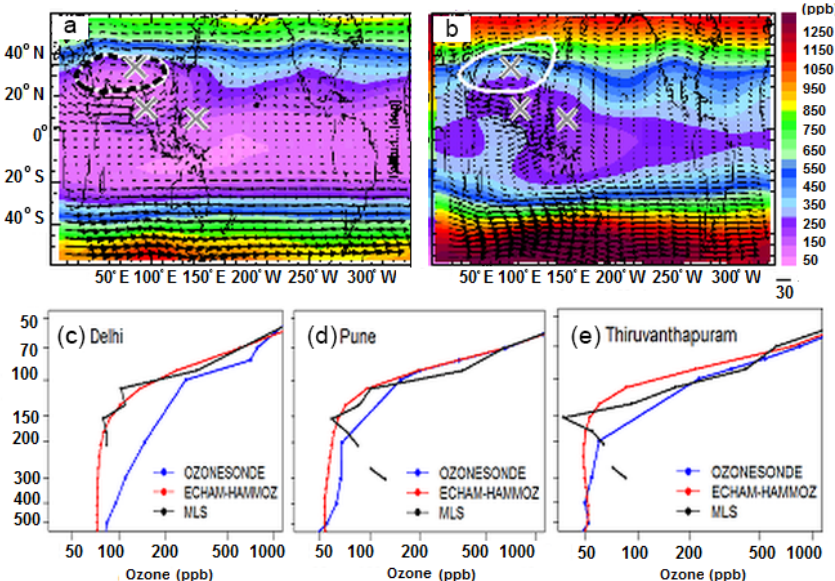
Figure 1. Distribution of ozone mixing ratio (ppb) during the monsoon season (June–September) obtained from (a) MLS observations at 100hPa and (b) ECHAM5-HAMMOZ at 90hPa. Black arrows indicate wind vectors, the black dashed contour shows the PV-gradient- based transport barrier of the anticyclone (calculated following Ploeger et al., 2015), and the white contour shows the 270m geopotential height anomaly, corresponding to the anticyclone edge definition by Barret et al. (2016). Meteorological data show climatological July fields from (a) ERA-Interim reanalysis and (b) ECHAM5-HAMMOZ. The ECHAM5-HAMMOZ ozone distribution is smoothed using the MLS averaging kernel. Grey crosses highlight the regions of the Tibetan Plateau, Bay of Bengal, and South China Sea. Bottom panels show the vertical distribution of seasonal (June–September) mean ozone mixing ratios (ppb) from ozonesonde (2001–2009), MLS (2004–2013) and ECHAM5-HAMMOZ CTRL simulation at the (c) Delhi, (d) Pune, and (e) Thiruvananthpuram Indian